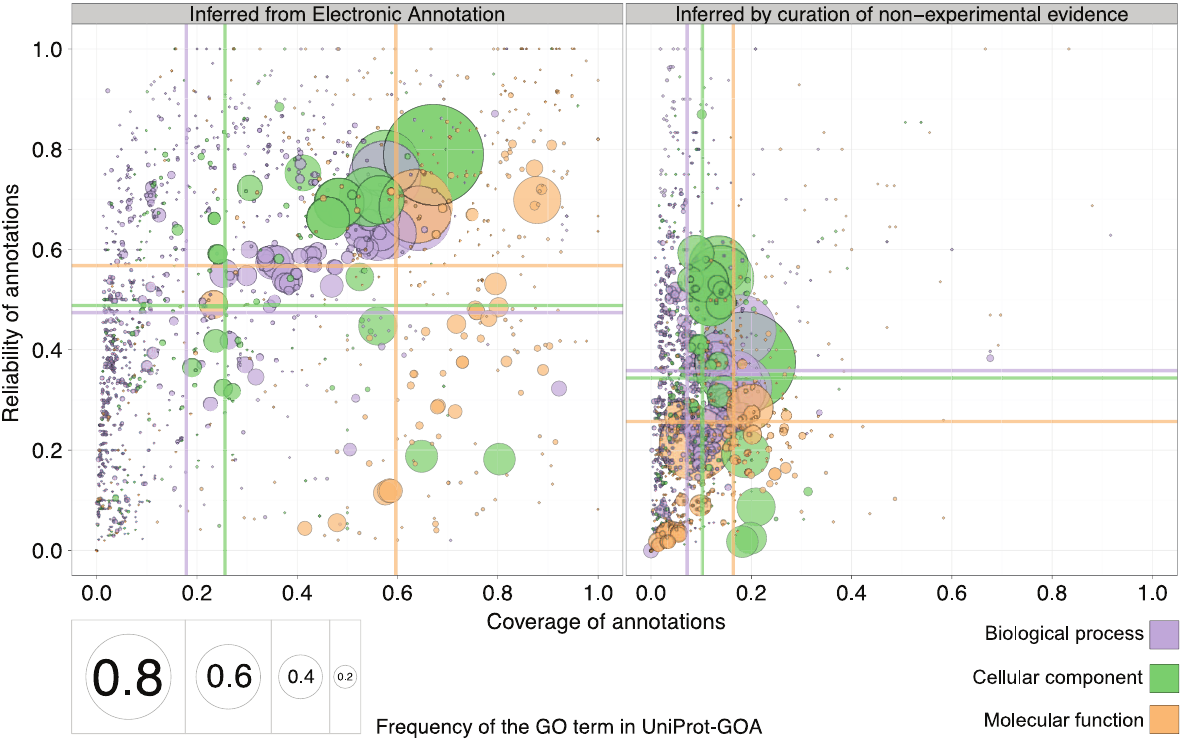
Figure 8. Quality of electronic and curated annotations on a common set of GO terms. Quality of the 16-01-2008 UniProt-GOA release is evaluated by the 11-01-2011 UniProt-GOA release; coverage is on the x-axis and reliability is on the y-axis. The ontology is denoted by the color of the disc, while the area of the disc reflects the frequency of the GO term in the 16-01-2008 UniProt-GOA release. The colored lines correspond to the mean values for the respective axes. To be visualized in the plot, a GO term needs to have assigned at least 10 electronic/curated annotations in the 16-01-2008 UniProt-GOA release, and at least 10 experimental annotations in the 11-01-2011 UniProt-GOA release.